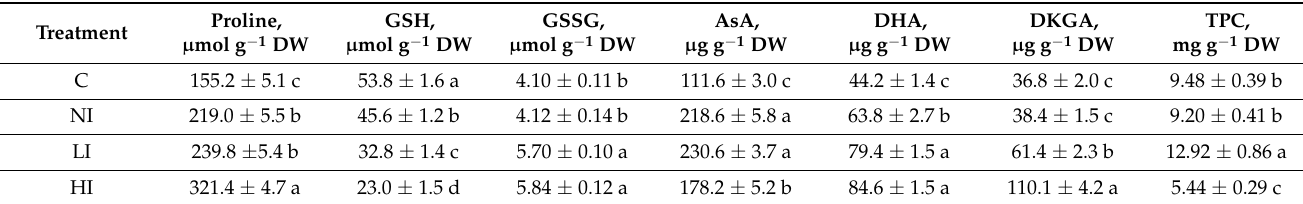
Table 3. Effect of mistletoe infestation on contents of non-enzymatic antioxidants in linden leaves. Proline, Treatment µ mol g − 1